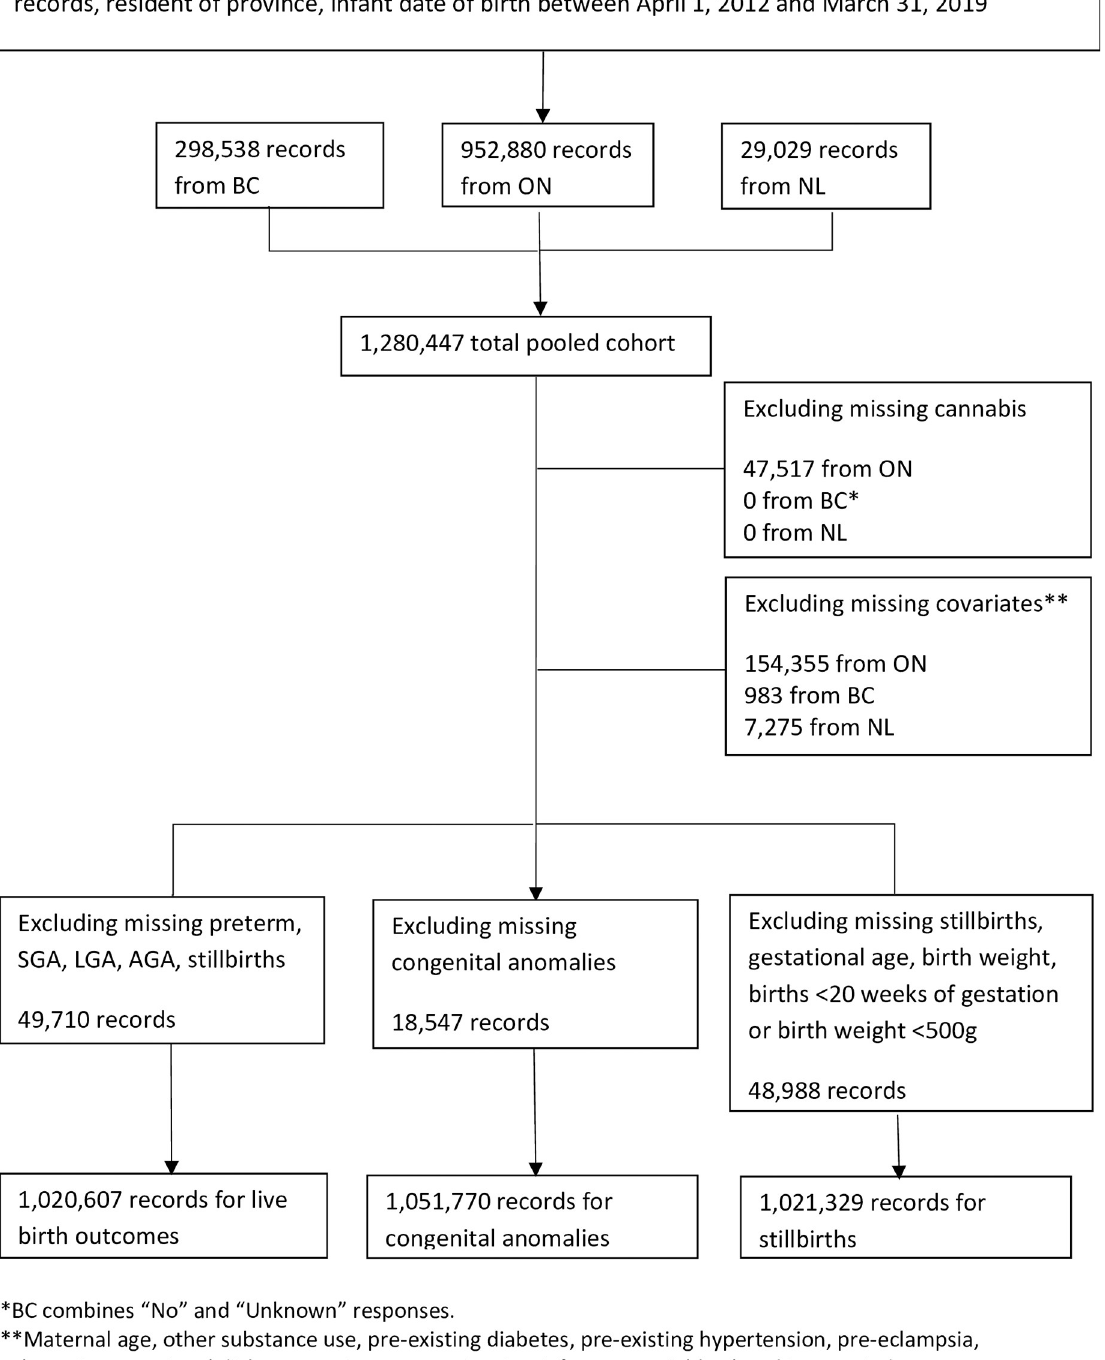
Fig 1. Flowchart of study cohort. � BC combines “No” and “Unknown” responses. �� Maternal age, other substance use, pre-existing hypertension, pre-eclampsia, eclampsia, gestational diabetes, parity, community size, infant sex, neighborhood income index.